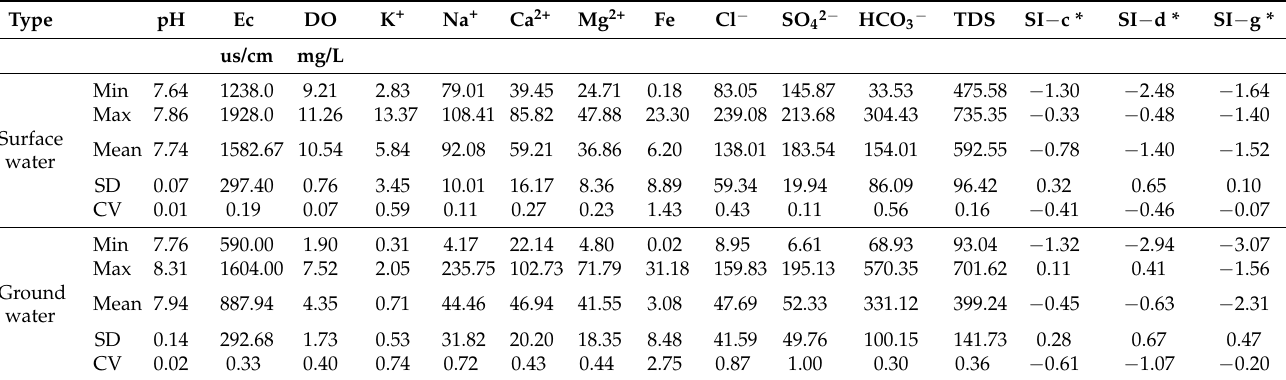
Table 1. Hydrochemical composition and saturation index of surface water and groundwater samples in the coal mining distric.